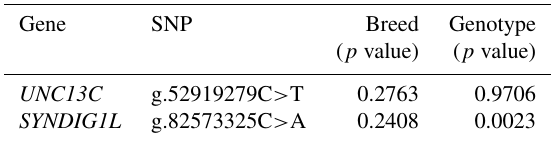
Table 5. Genotypes of candidate locus and the number of thoracic vertebrae in a single breed by Fisher’s exact test.